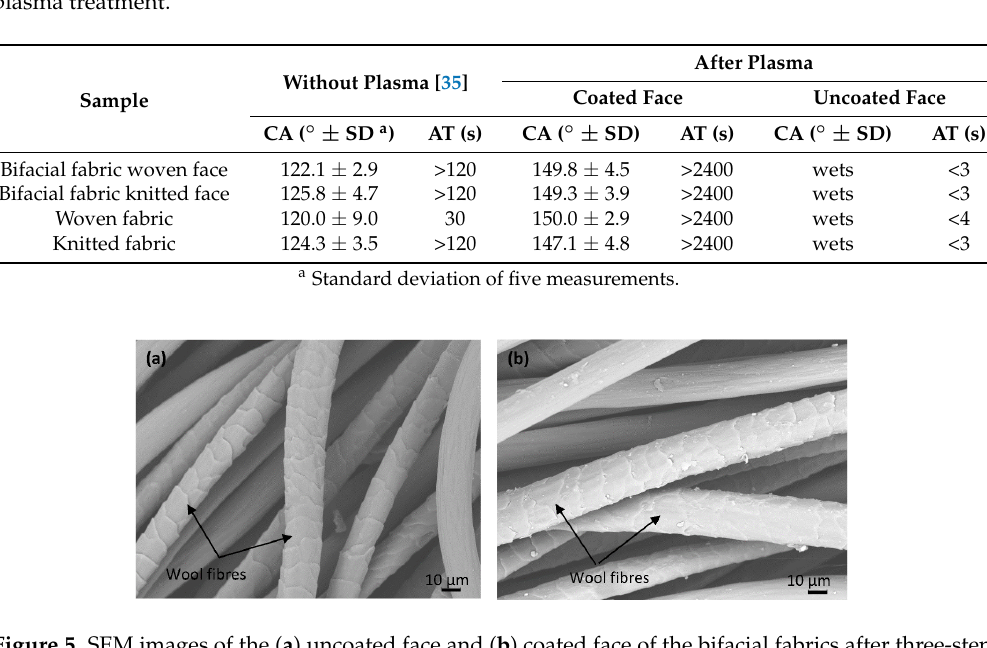
Figure 5. SEM images of the ( a ) uncoated face and ( b ) coated face of the bifacial fabrics after three-step plasma treatment.